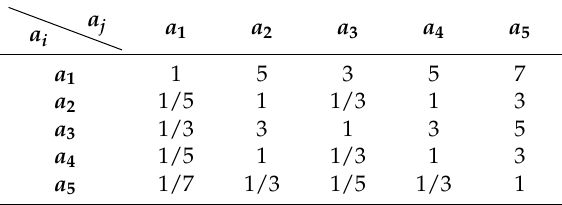
Table 3. The importance table of pairwise comparison among evaluation